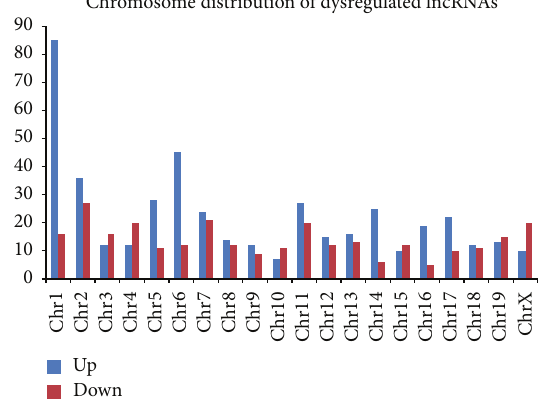
Figure 3: Chromosome distribution of up- and downregulated lncRNAs location in different